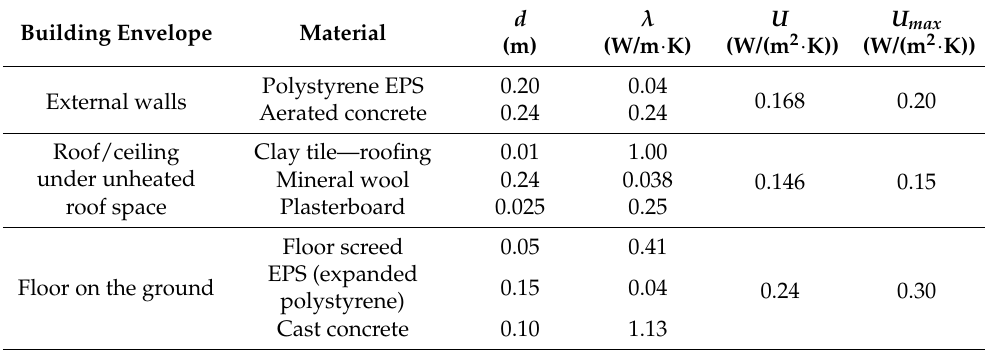
Table 2. Thermal properties of the building envelope materials and the heat transfer coefficient obtained in the analyzed building ( U ) and required in Poland ( U max ).